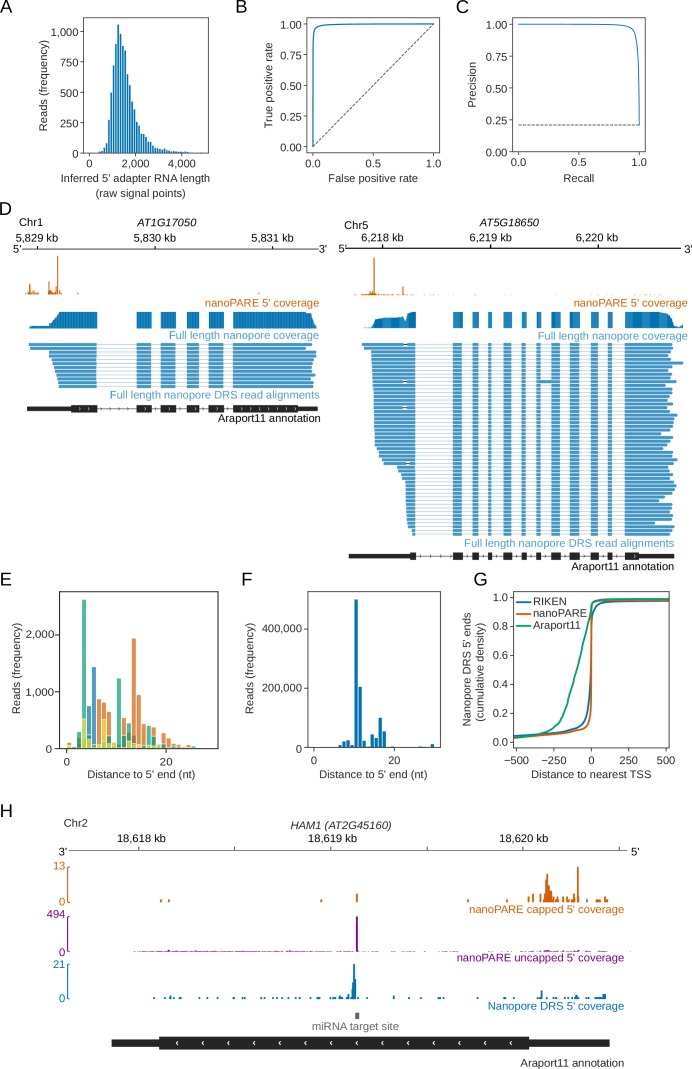
Nanopore DRS with cap-dependent ligation of 5′ adapter RNA.(A) Histogram showing the distribution of 5′ adapter RNA length in the nanopore raw current signal, as inferred from alignment of the mRNA sequence to the signal using nanopolish eventalign. The median signal length was 1441 points and 96% of adapter signals were 3000 points or less. (B) Out-of-bag receiver operator characteristic curve showing the performance of the trained convolutional neural network at detecting 5′ adapter RNA using 3000 points of signal. The curve was generated using five-fold cross validation. (C) Out-of-bag precision recall curve showing the performance of trained neural network, generated using five-fold cross validation. (D) Alternative transcription start sites were identified using nanopore DRS with cap-dependent ligation of a 5′ end adapter at the AT1G17050 and AT5G18650 genes. Orange, 5’ coverage for capped nanoPARE reads; blue track, nanopore DRS coverage with cap-dependent ligation of 5′ adapter RNA; blue, isoforms detected by nanopore DRS with cap-dependent ligation of 5′ adapter RNA; black, Araport11 annotation. (E) Reads mapping to ERCC RNA spike-ins lack approximately 11 nt of sequence at the 5′ end. Histogram showing the distance to the 5′ end for ERCC RNA spike-in reads (each spike-in is shown in a different colour; only those with > 1000 supporting reads are shown). (F) Reads mapping to in vitro transcribed mGFP lack approximately 11 nt of sequence at the 5′ end. Histogram showing the distance to the 5′ end for in vitro transcribed mGFP. (G) Araport11 annotation overestimates the length of 5′ UTRs. The cumulative distribution function shows the distance to the nearest TSS identified from full-length transcripts cloned as part of the RIKEN RAFL project (blue) and Araport11 annotation (orange). (H) Nanopore DRS detects miR170/miR171 cleavage products of Hairy Meristem 1 (HAM1, AT2G45160) transcripts. Orange, 5’ coverage from capped nanoPARE reads; purple, 5’ coverage from uncapped nanoPARE reads; blue, nanopore DRS 5’ coverage; grey, miRNA target site alignment is shown; black, Araport11 annotation.Figure 3—figure supplement 1—source data 1.microRNA cleavage site predictions supported by enrichment of nanopore 5’ ends – Figure 3—figure supplement 1H.